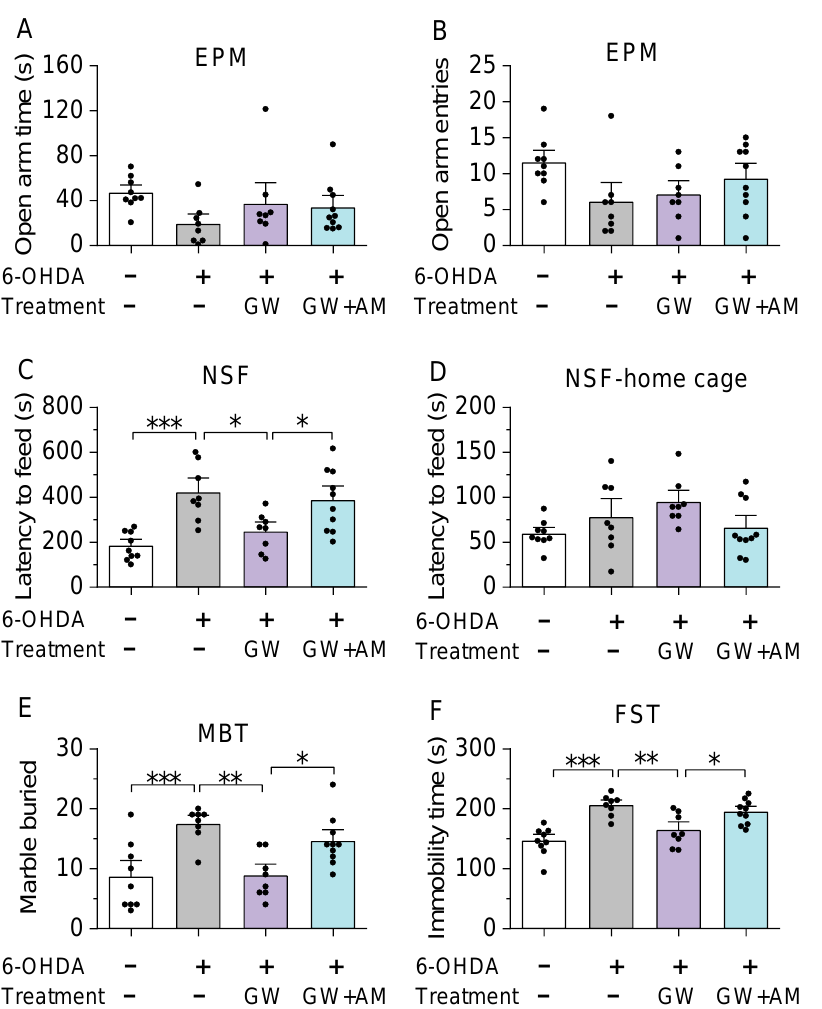
Figure 6. GW treatment attenuated 6-OHDA-induced deficits in the elevated plus-maze (EPM) test, novelty-suppressed feeding (NSF) test, marble burying test (MBT), and forced swim test (FST). ( A , B ) In the EPM test, neither 6-OHDA or drug treatments had a significant effect on open arm time (( A ) p > 0.05) or the number of open arm entries (( B ) p > 0.05). ( C , D ) In the NSF test, 6-OHDA injection increased feeding latency in a novel environment (( C ) *** p < 0.001; n = 8 – 9 mice) compared to the controls. GW treatment prevented the increase in latency to feed in a novel environment (* p = 0.015; n = 8 – 8 mice), but co-treatment with AM blocked the effect of GW (* p = 0.049; n = 8 – 10 mice). However, when returned to the home cage ( D ) 6-OHDA injection and GW treatment had no effect ( p > 0.05). ( E ) In the MBT, 6-OHDA injection increased the number of marbles buried (*** p < 0.001; n = 8 – 9 mice). Treatment with GW blocked the increase in marble burying (* p = 0.002; n = 8 – 8 mice), and co-treatment with AM prevented the effect of GW (* p = 0.037; n = 8 – 10 mice). ( F ) 6-OHDA injection increased immobility time in the FST (*** p < 0.001; n = 8 – 9 mice), which was ameliorated by treatment with GW (** p = 0.004; n = 8 – 8 mice). The effect of GW was blocked by AM co-treatment (* p = 0.035; n = 8 – 10 mice).